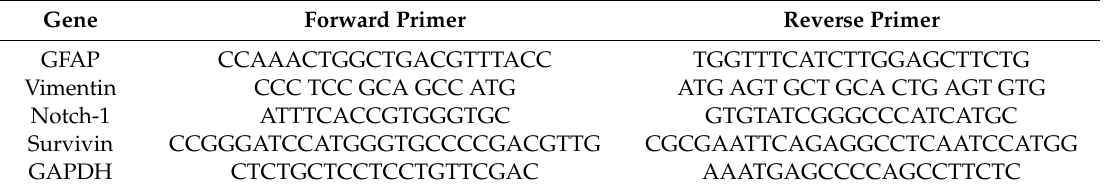
Table 1. Primer sequences used in quantitative polymerase chain reaction